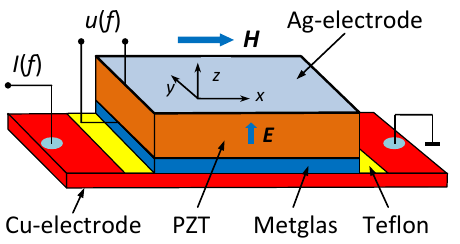
Figure 9. Schematic view of the Metglas/PZT heterostructure excited by a strip with ac current I . The arrows show directions of electric E and magnetic H fields.